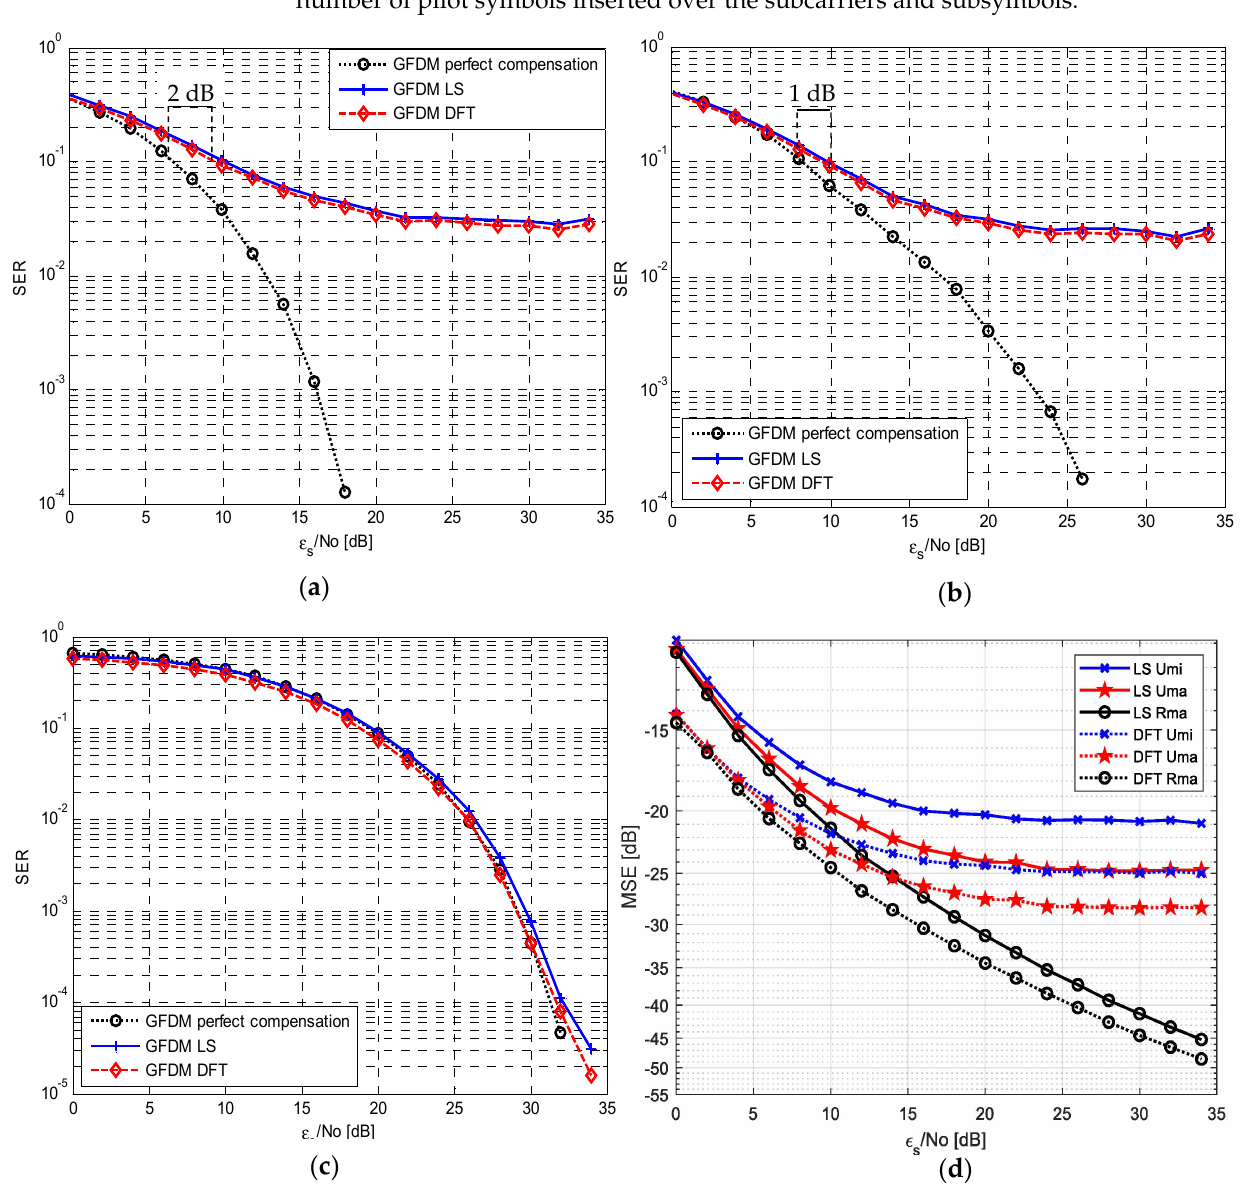
Figure 7. SER and MSE performance: ( a ) SER performance for Umi scenario; ( b ) SER performance for Uma scenario; ( c ) SER performance for Rma scenario; ( d ) MSE performance for all scenarios.